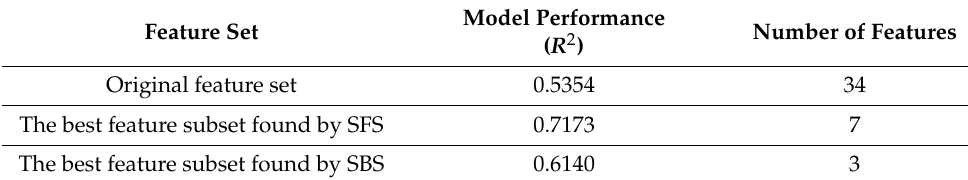
Table 7. Results of feature selection using CARTs.